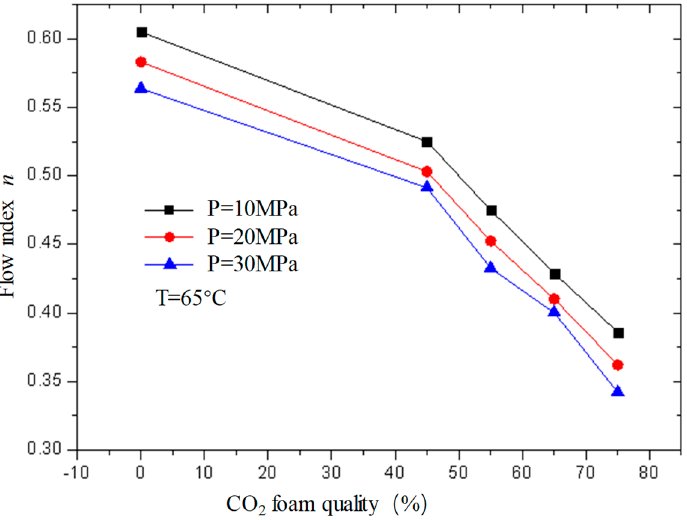
Figure 13. Variation curve of flow index n with foam quality under different pressures (foamed).